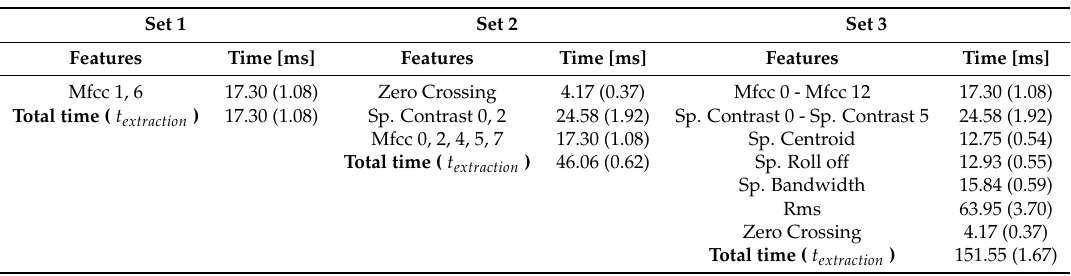
Table 7. Considered feature sets and average time required for the features’ extraction. The values in brackets are the Standard Deviation